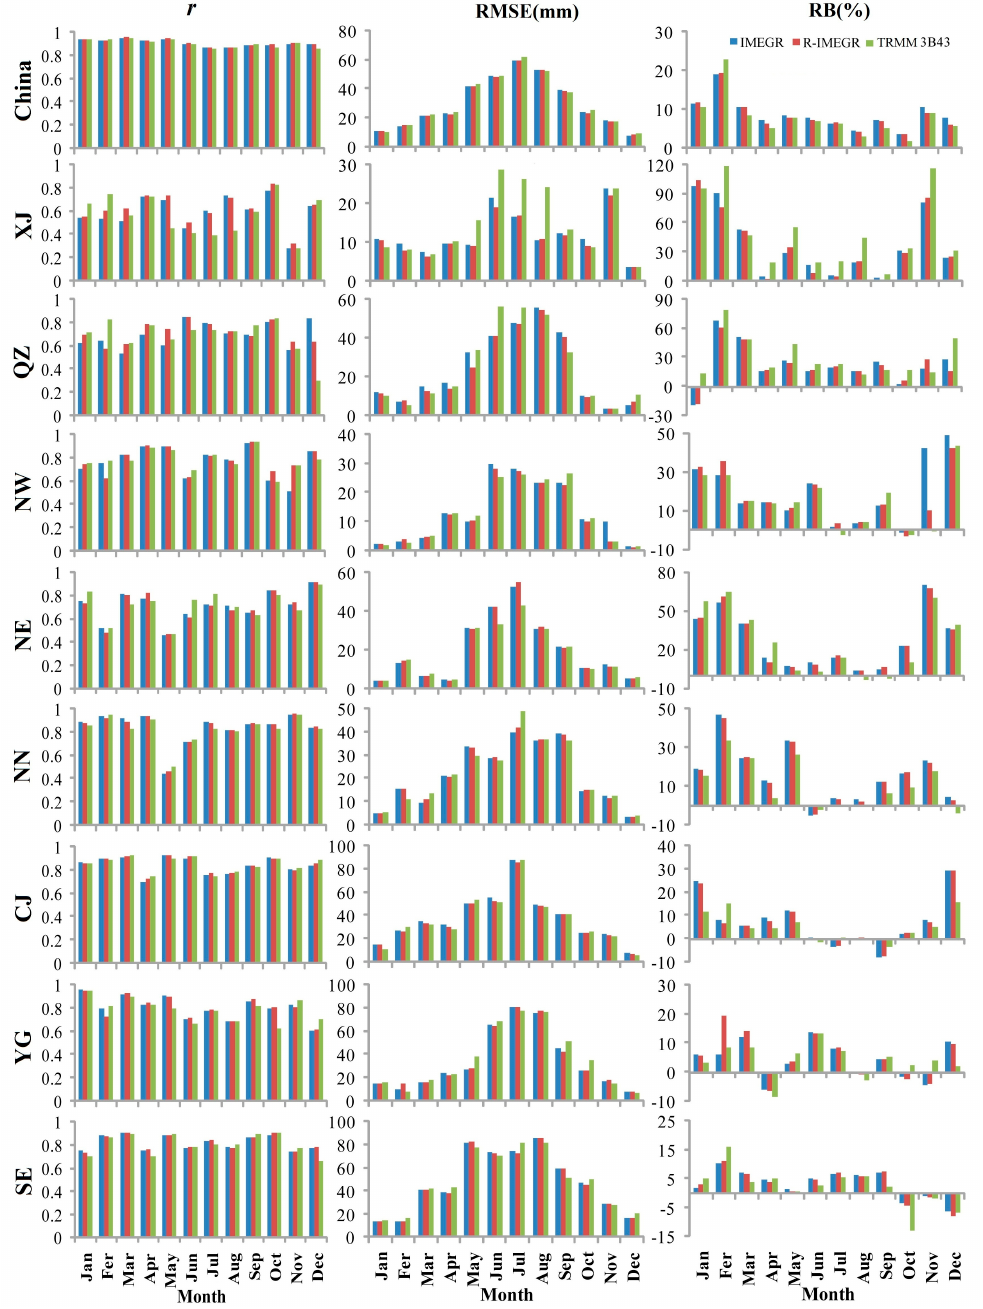
Figure 8. r , RMSE and RB values of monthly precipitation estimates derived from IMERG, R-IMERG, and TRMM 3B43 products over Mainland China and its eight sub-regions.